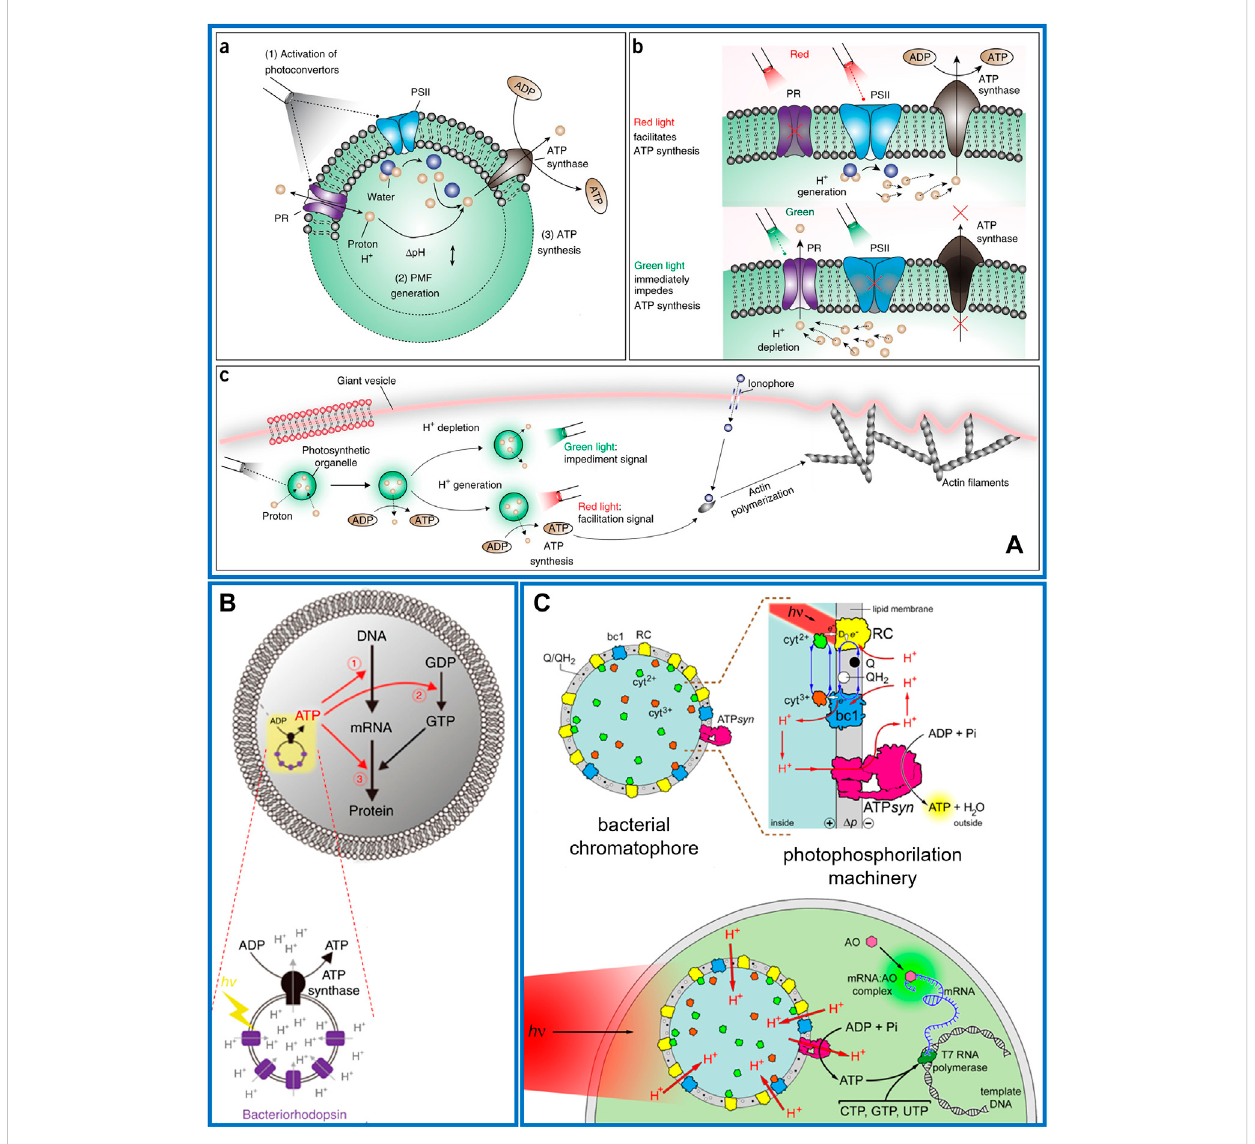
FIGURE 2 Photosynthetic multicompartment arti fi cial cells. (A) a) Nanometric lipid vesicle with two complementary photoconverters (PSII and PR)and an ATP synthase reconstituted into the membrane. (b) Red light illumination triggers PSII that generates a proton gradient across the lipid membrane then exploitedbyATPsynthaseforATPsynthesis.GreenlightactivatesPRcausingprotondepletionandimpedingATPsynthesis.(c)Photosyntheticliposomes used as organelle energy modules when encapsulated in a giant vesicle, for actin polymerization and morphological change of the vesicle after optical stimulation (Lee et al., 2018). (B) Schematic representation of a giant lipid vesicles encapsulating nanometric liposome as arti fi cial photosynthetic organelle, which consists of BR and ATP synthase. The ATP photo-produced can sustain mRNA synthesis ( ➀ ), guanosine diphosphate (GDP) phosphorylation ( ➁ ) or tRNA aminoacylation ( ➂ ) (Berhanu et al., 2019). (C) Chromatophores extracted from R. sphaeroides are encapsulated inside giant phospholipid vesicles made of POPC and illuminated to generate a proton motive force ( Δ p ~ 130 mV) across the membrane. Co-encapsulated ADP, Pi, GTP, CTP, UTP, T7 RNA polymerase (dark green), and a DNA template give rise to an out-of-equilibrium system of coupled reactions: namely, photophosphorylation and DNA transcription. The biosynthesized mRNA is revealed by acridine orange (AO, pink), which binds it, forming a green- fl uorescent complex (Altamura et al.,